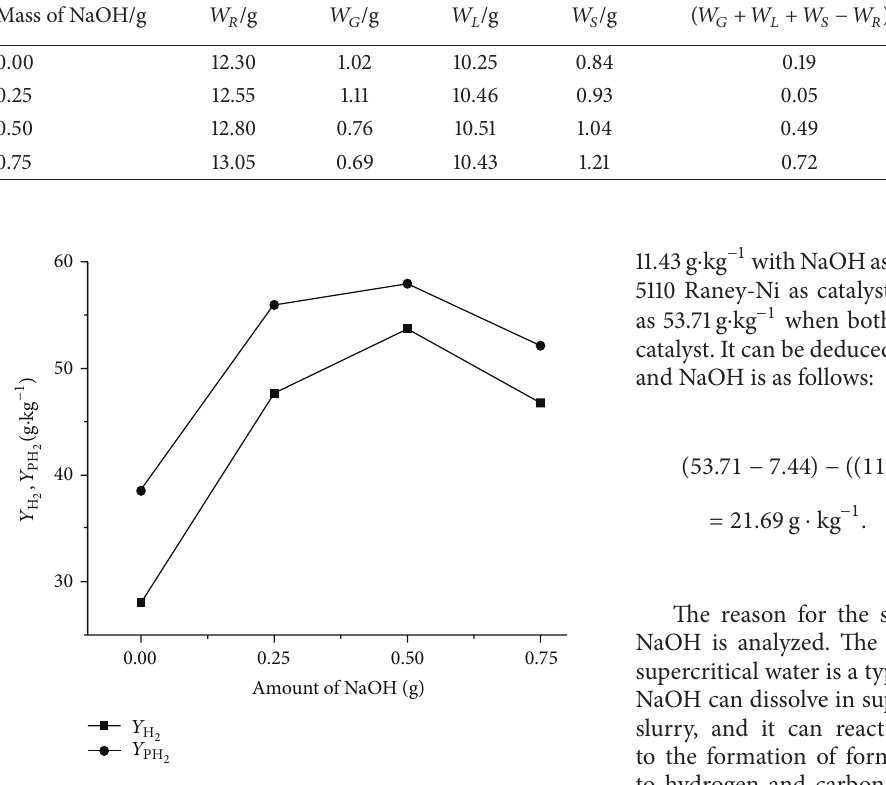
Figure 3: The hydrogen yield and hydrogen yield potential by supercritical water gasification of peanut shell versus the amount of NaOH (water :CMC:biomass:Raney-Ni = 10g:0.3 g:1g:1g, temperature: 400 ∘ C, and residence time: 20